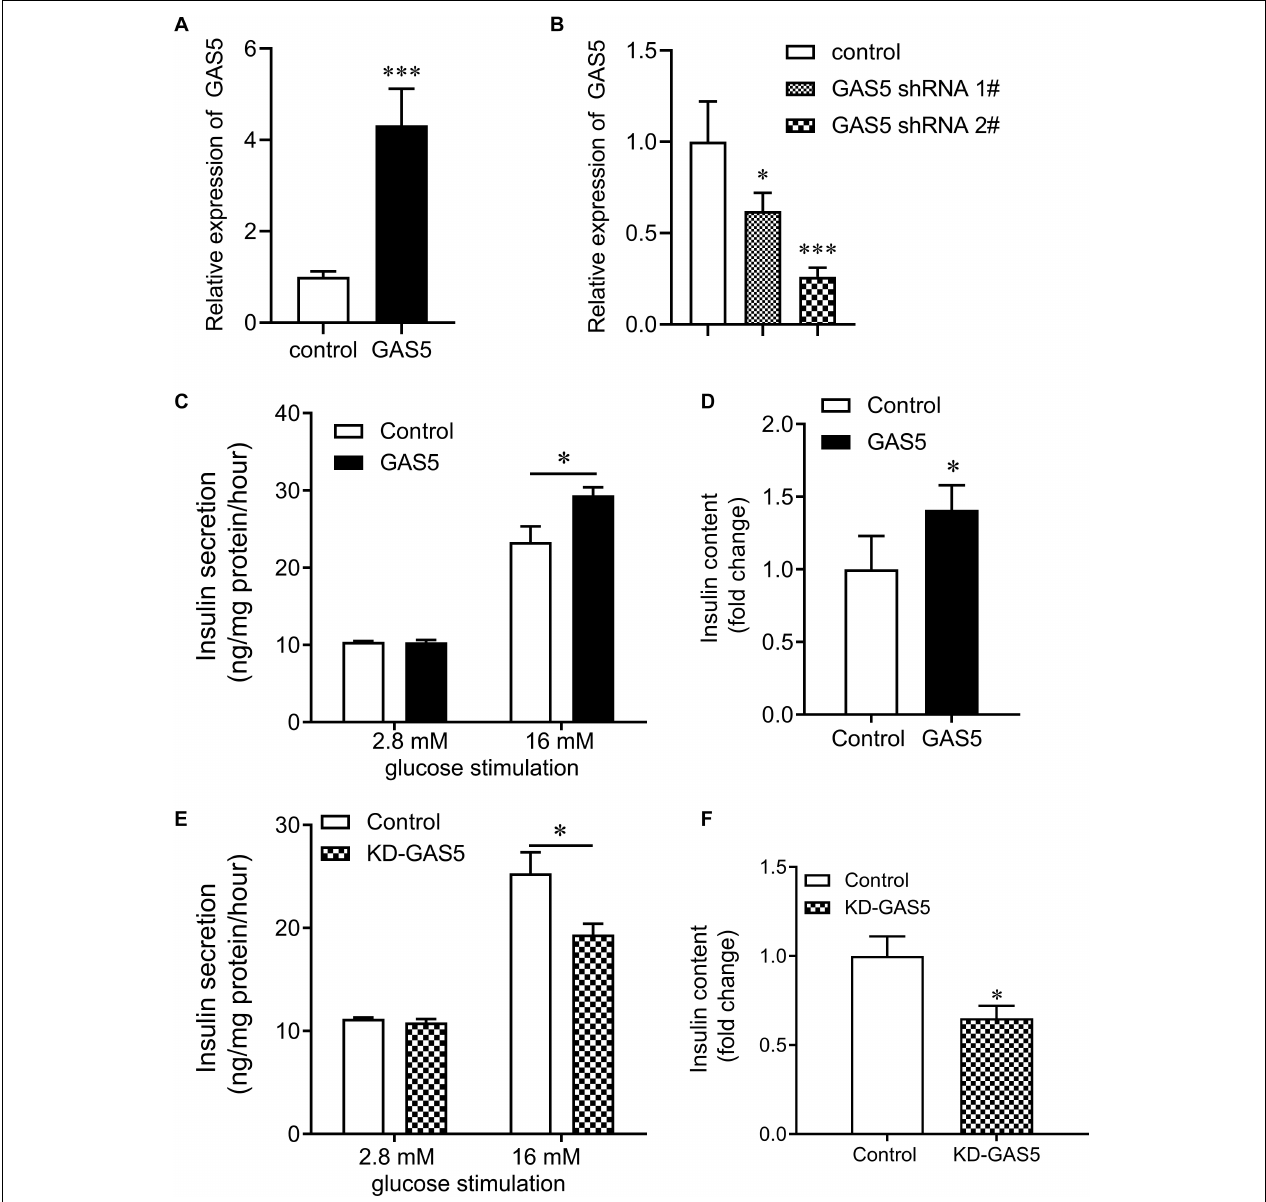
FIGURE 3 | Effects of GAS5 on glucose stimulated insulin secretion in NS-1 832/13 cells. (A) QPCR was performed to determine the expression of GAS5 in INS-1 832/13 cells after transfection with lentivirus carrying GAS5 DNA sequence or empty pReceiver-Lv218 vector control. (B) QPCR was performed to determine the expression of GAS5 in INS-1 832/13 cells after transfection with lentivirus carrying GAS5 shRNA sequence or scramble control. (C) Insulin secretion in GAS5 overexpressed INS-1 832/13 cells after 2.8 mM or 16 mM glucose stimulation. (D) Insulin content in INS-1 832/13 cells after GAS5 overexpression. (E) Insulin secretion in GAS5 knocked down INS-1 832/13 cells after 2.8 or 16 mM glucose stimulation. (F) Insulin content in INS-1 832/13 cells after GAS5 knockdown. KD, knockdown. * p <